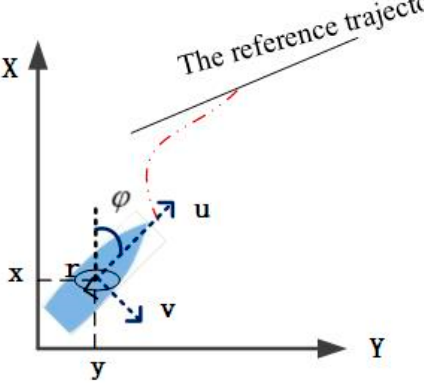
Figure 1. Ship motion structure.